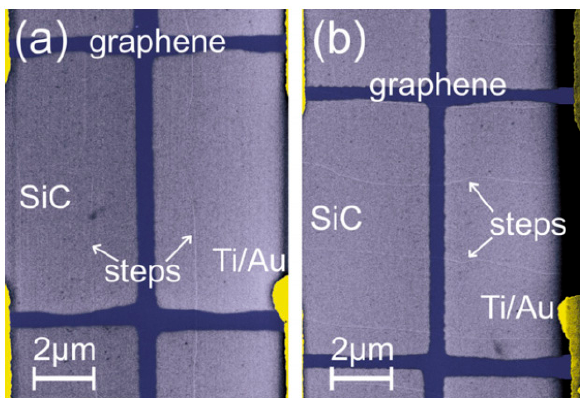
Figure 5. Scanning electron microscopy images of Hall bars fabricated on MLG ( a ) on a flat terrace and ( b ) perpendicular to the step edges on 6H-SiC. Reprinted with permission from Reference [55]. Copyright (2011) Elsevier Ltd.